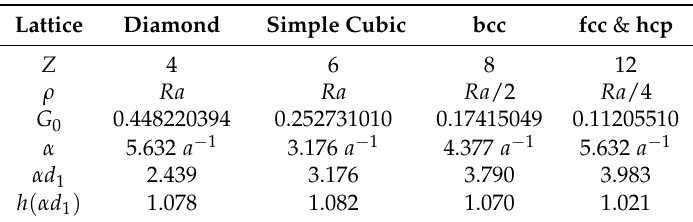
Table 1. Coordination Z , apparent resistivity ρ , value G 0 of the diagonal elements of the topological lattice Green’s function (values from [40]), scaling factor α (Equation (7)), α times the bond length d 1 , and the correction function at d 1 (Equation (11) for a few 3D infinite lattices. R is the bond resistance, and a is the lattice parameter of the conventional cubic cell. Lattice Diamond Simple